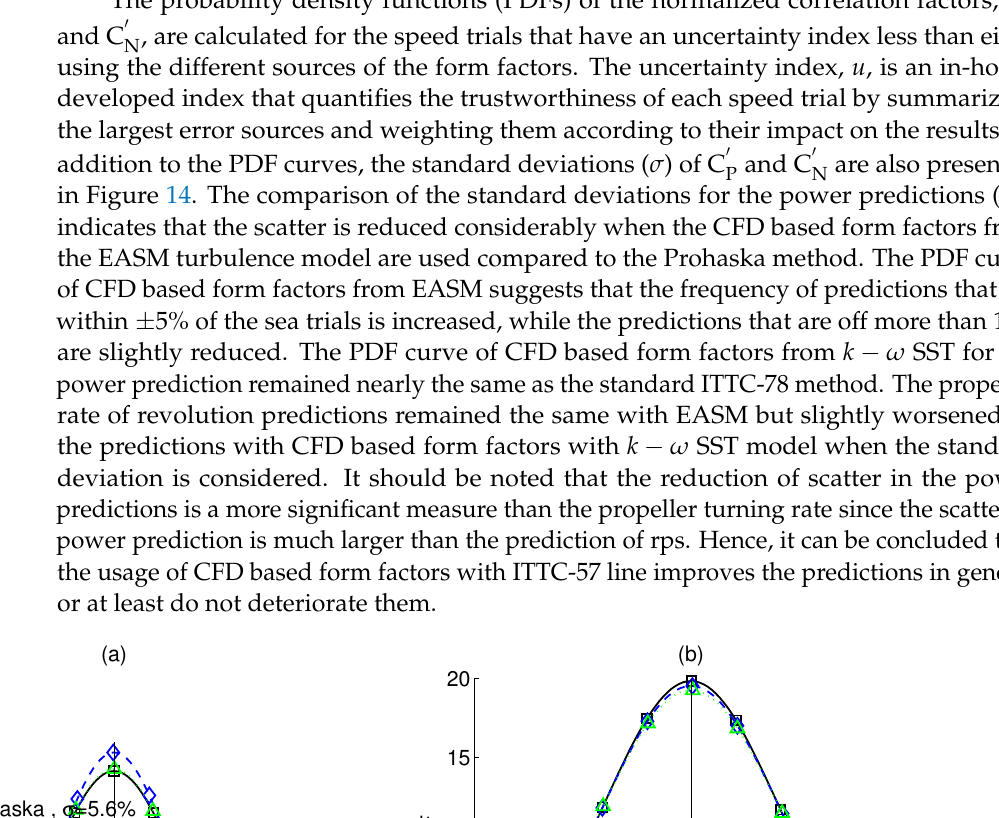
and ( b ) C (cid:48) P N